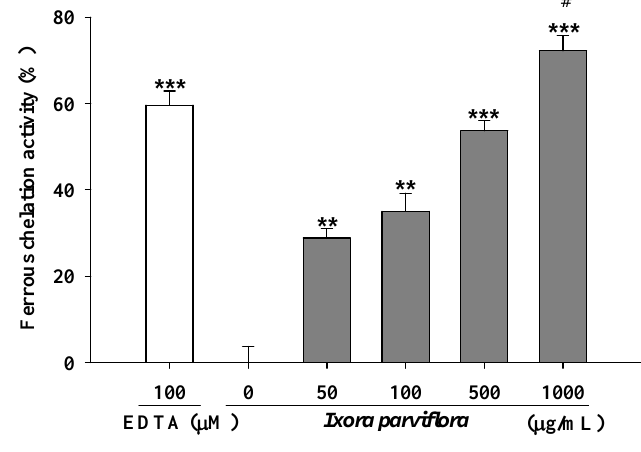
Figure 4. Ferrous chelation activity of IPE. EDTA was applied as positive control. (n = 4; significant difference versus control (without extract): ** , P < 0.01; *** , P < 0.001; significant difference versus EDTA: # , P <